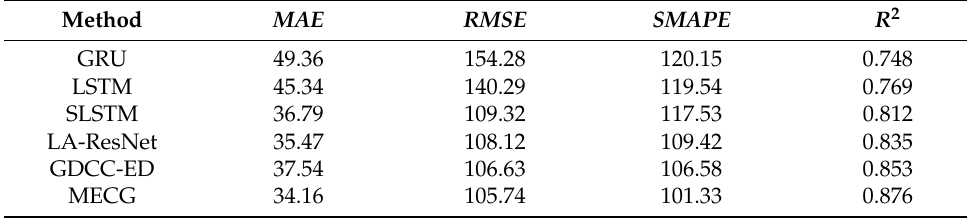
Table 4. Comparison of prediction performance of different